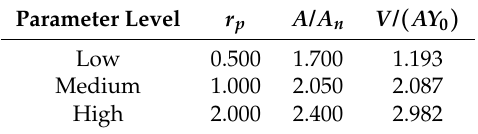
Table 1. Considered levels of parameters for the design of experiments of the ESR patterned samples.